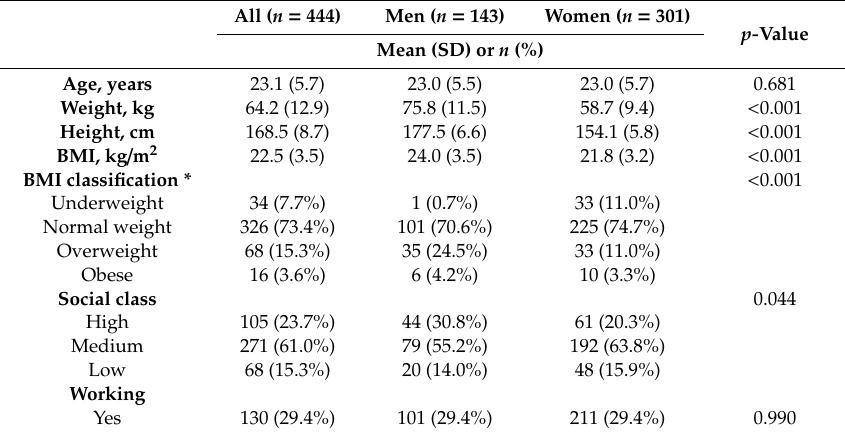
Table 1. General characteristics of participants ( n = 444).